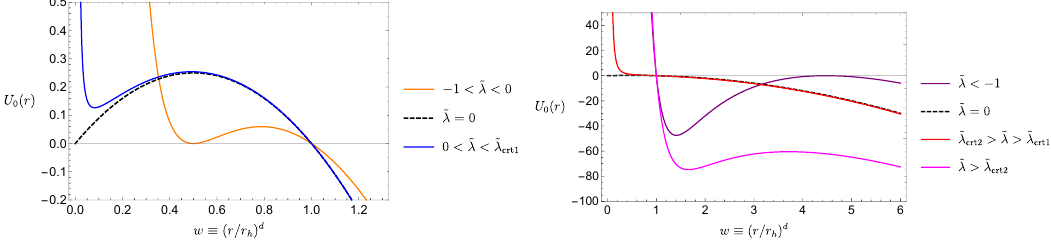
˜ ˜ λ < λ crt1 . Right: The effective potentials is associated with the existence of gen ). crt1